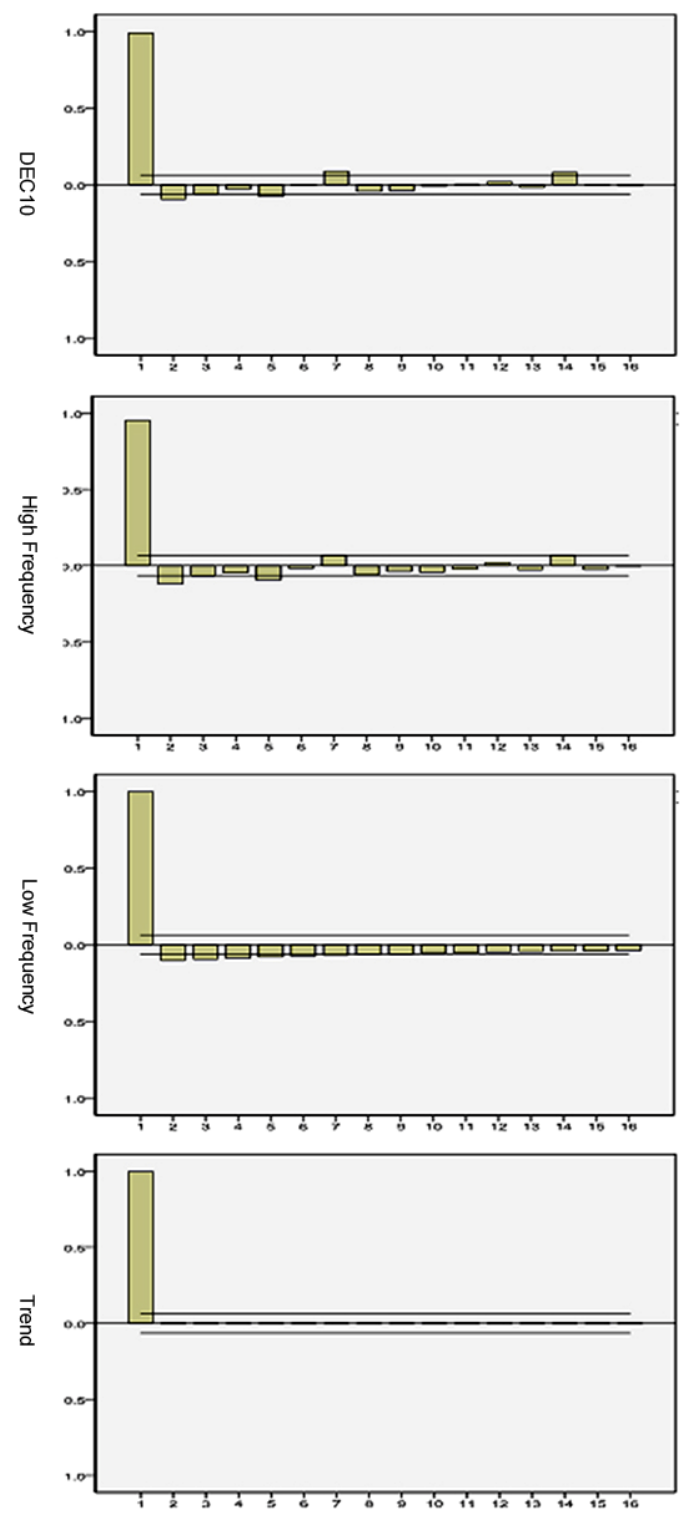
Figure 8. The PACFs of the original series and the reconstructed components of